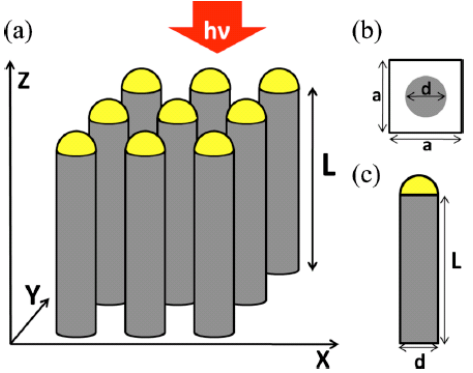
Figure 8. ( a ) Schematic of the Si NW array with hemispherical metal caps. ( b ) Top view